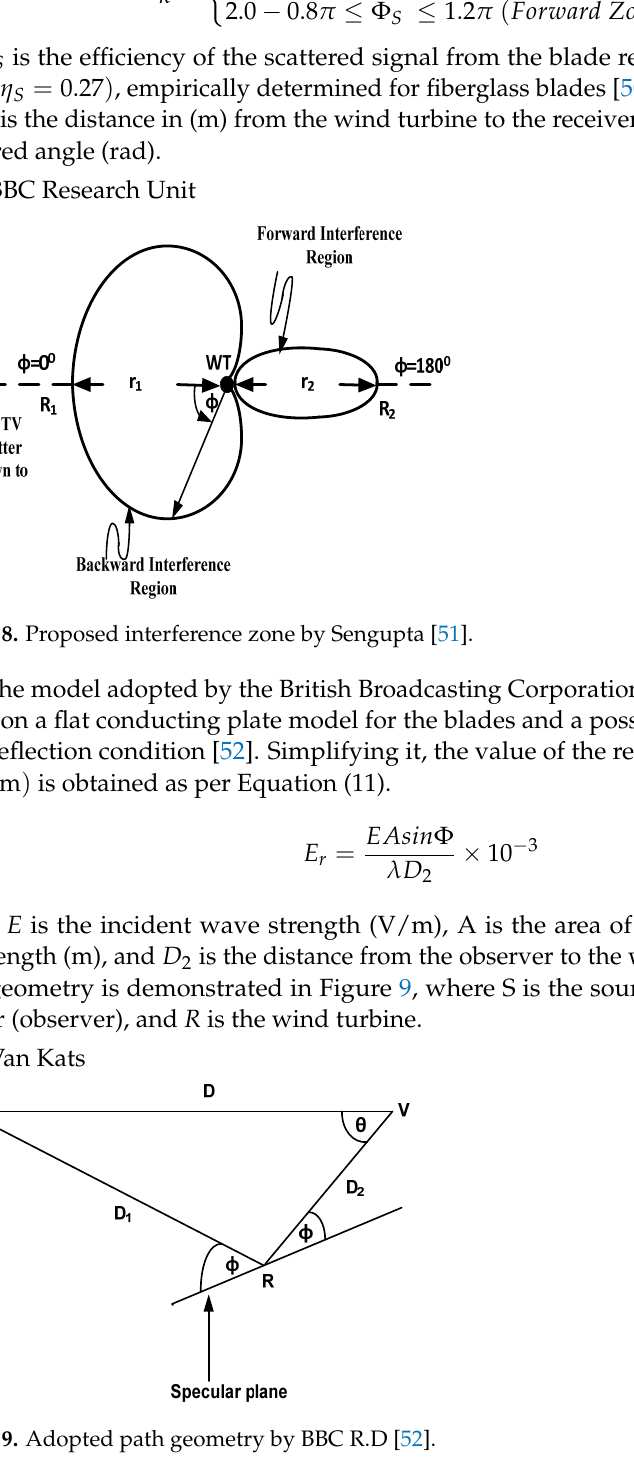
Figure 10. Adopted geometrical arrangement for the zone of co-ordination by Van Kats [54]. In terms of the co-ordination region, the blade was estimated using a rectangular ideal conducting screen, and the worst-case scattering condition of the wind turbine was considered as well. The RCS of the wind turbine is detailed in Equation (12). 𝜎(𝛼) = (cid:3428)4𝜋 𝜆 (cid:2870) 𝐴 (cid:2870) (cid:3436)1 + 𝑐𝑜𝑠𝛼 2